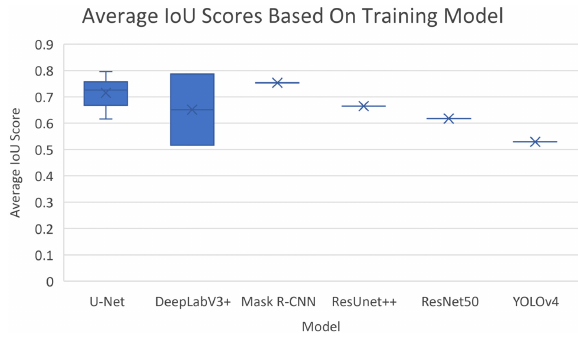
Figure 8. Average IoU scores based on training